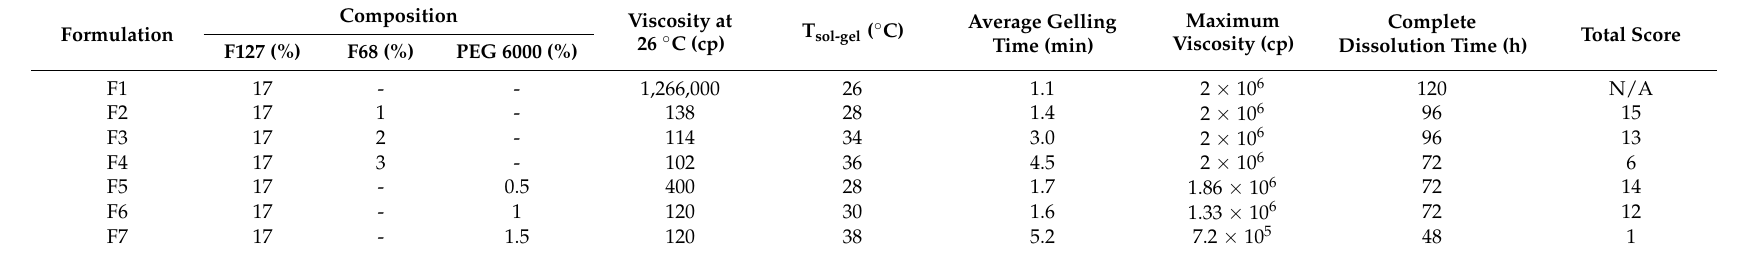
Table 5. Formulations, T sol-gel and gelation time of FTS thermo-sensitive